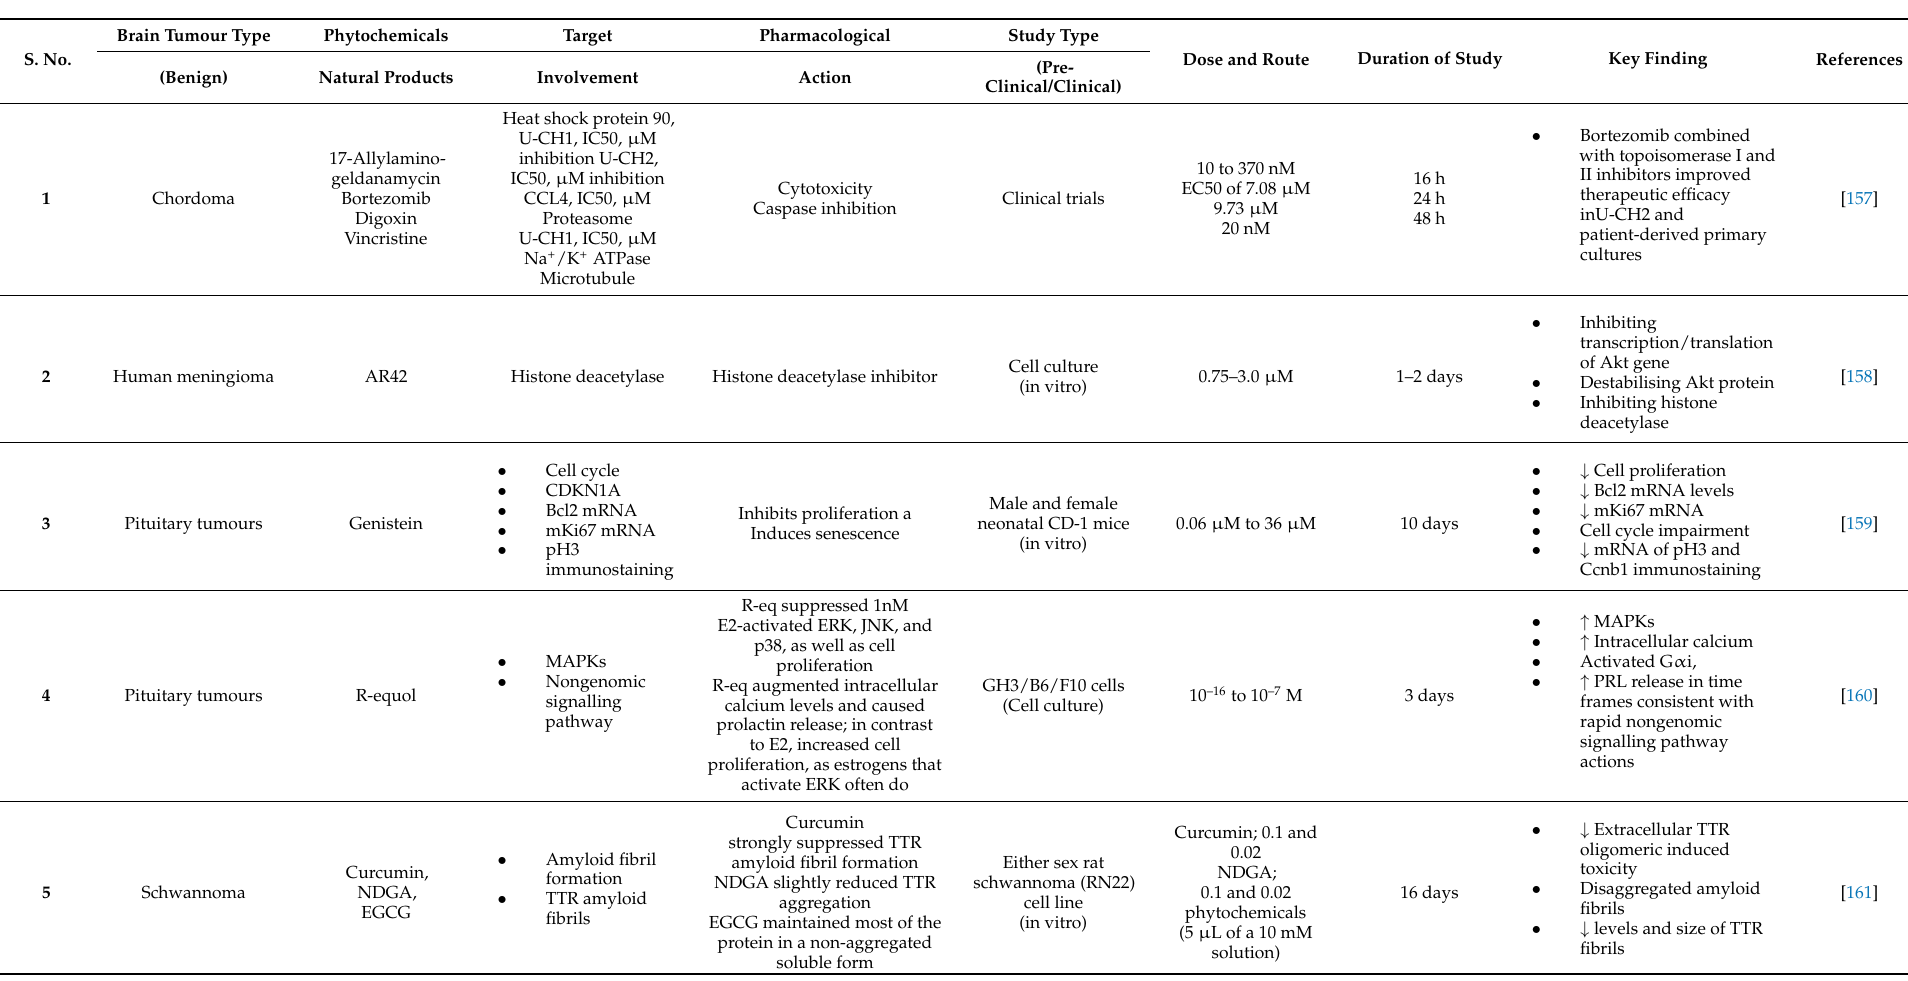
Table 1. Summarised nano-based phytochemicals/natural products in benign brain tumours. S.